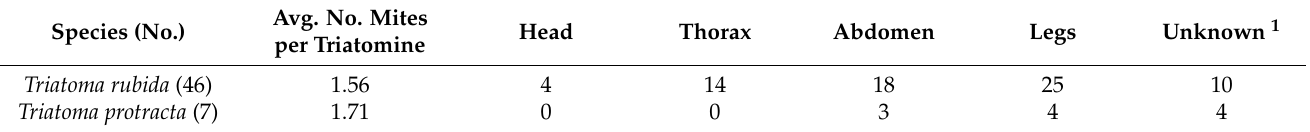
Table 2. Mite location and count on Triatoma rubida and Triatoma protracta specimens ( n = 53). Avg. No. Mites Head Thorax Abdomen Legs Unknown 1 Species (No.) per Triatomine